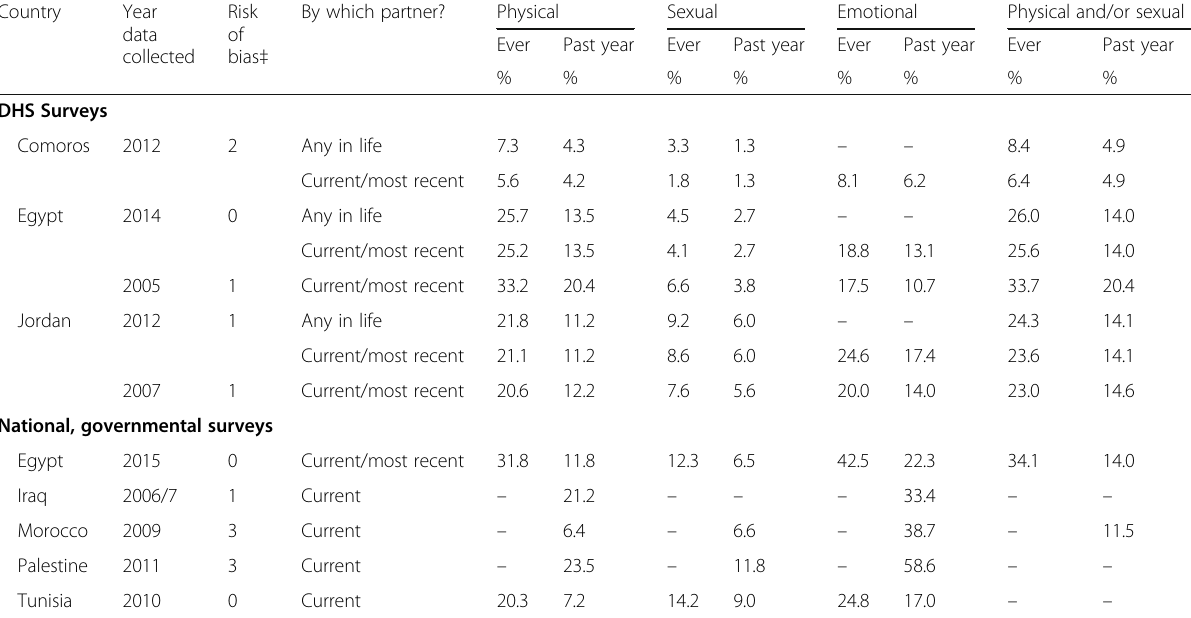
Table 6 Percentage of ever-partnered * women reporting IPV ever and past year, population-based DHS or governmental surveys Country